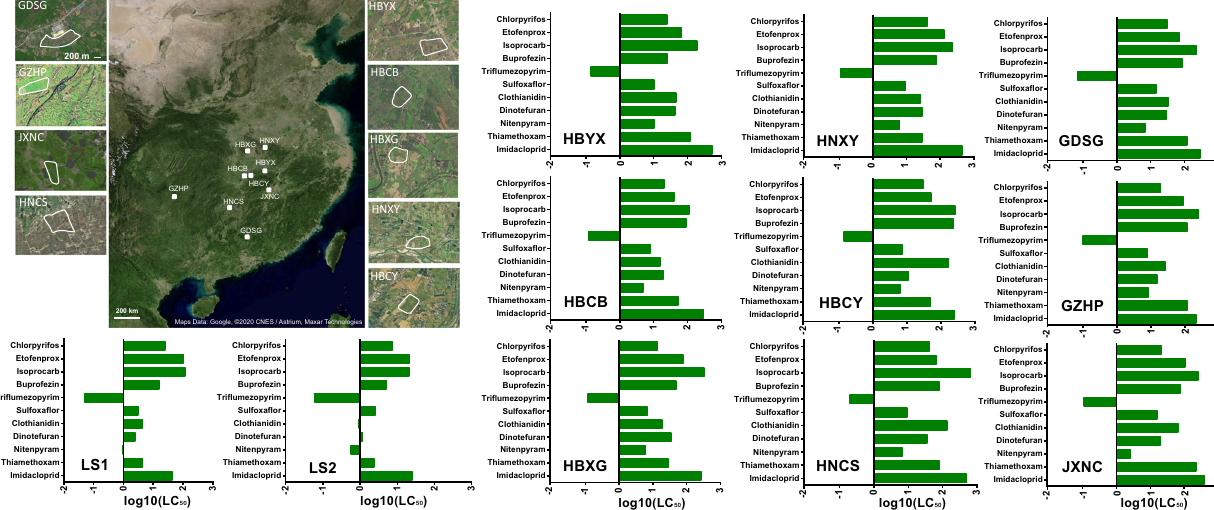
Fig. 1 Collection localities and susceptibility level for Nilaparvata lugens . The map was downloaded from Google Earth, the area where fi eld strains of N. lugens were collected is labeled with white boxes, and the scale bars for small maps were for 200 m. Detailed information on fi eld and laboratory strains of N. lugens were shown in Supplementary Table 1. The bar plot shows the susceptibility level [Log10 (LC of fi eld and laboratory strains of N. lugens to 11 insecticides.